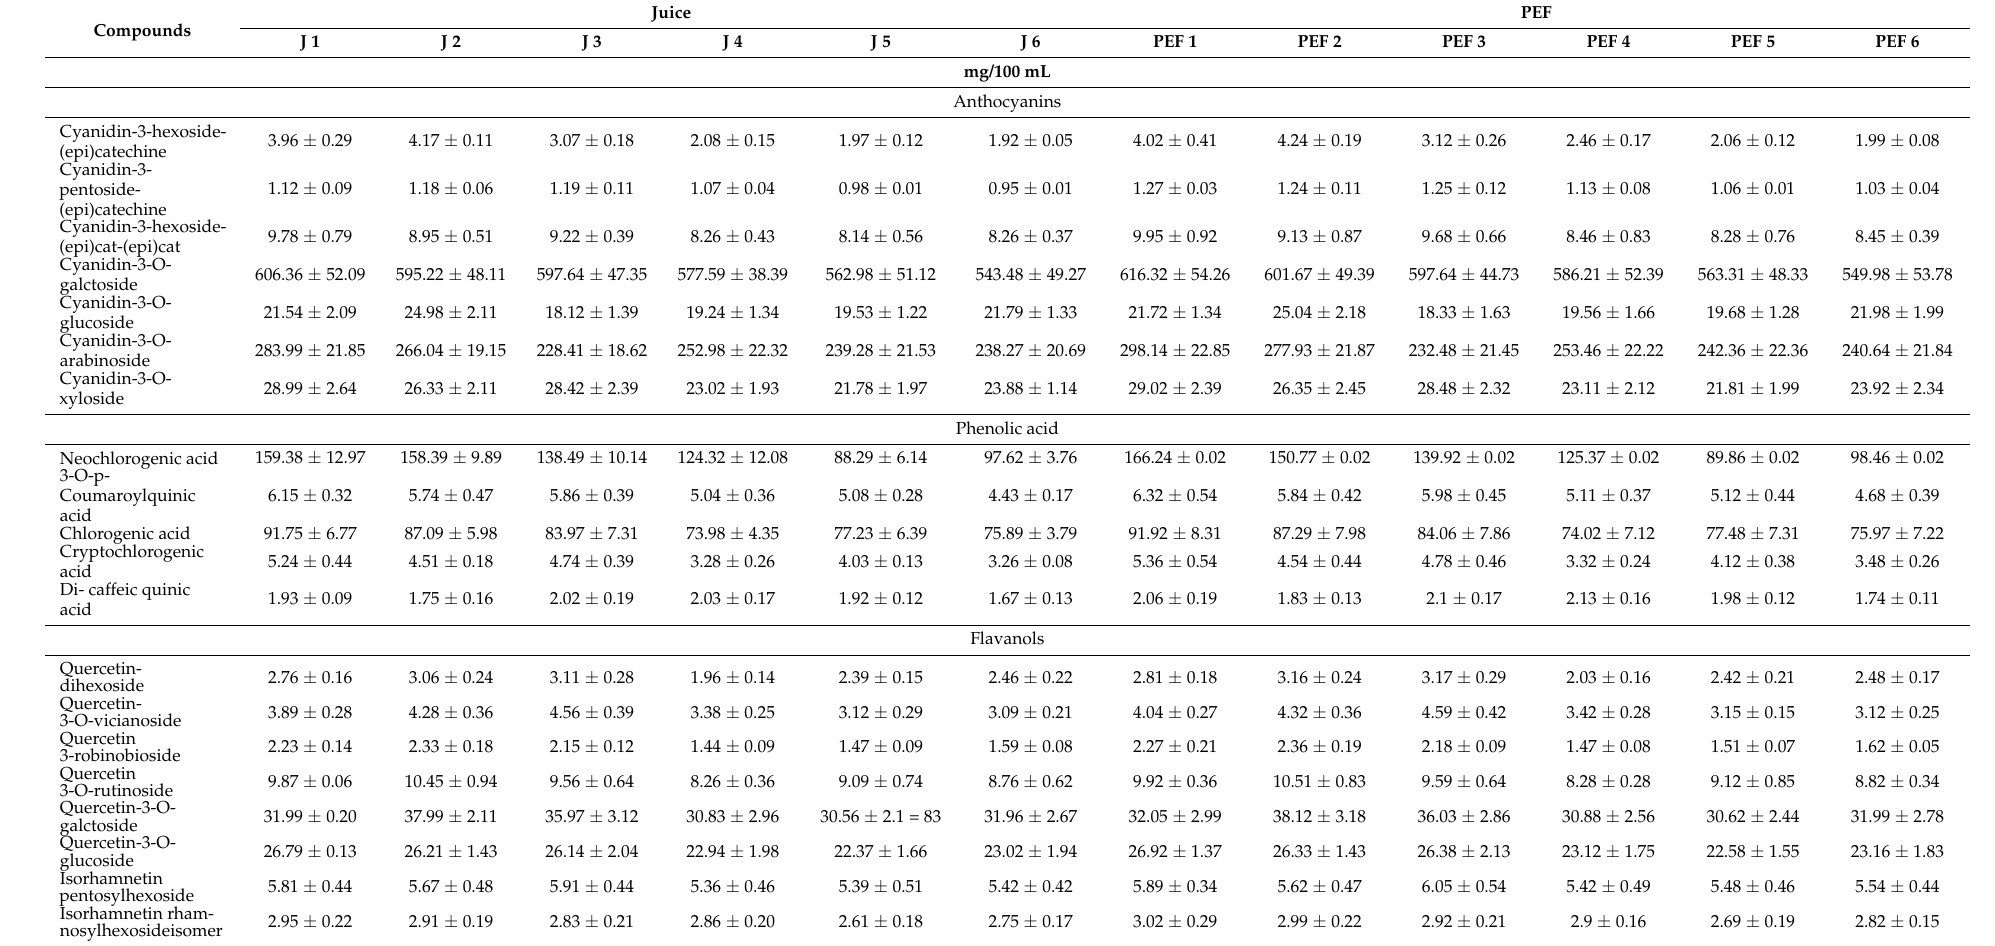
Table 4. Comparison of phenolic compounds detected in black chokeberry juice (mg/100